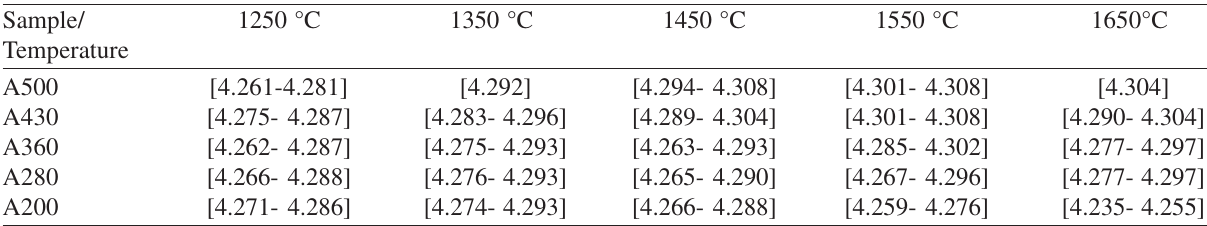
(Å) for Ti(C,O) phase in TiO o